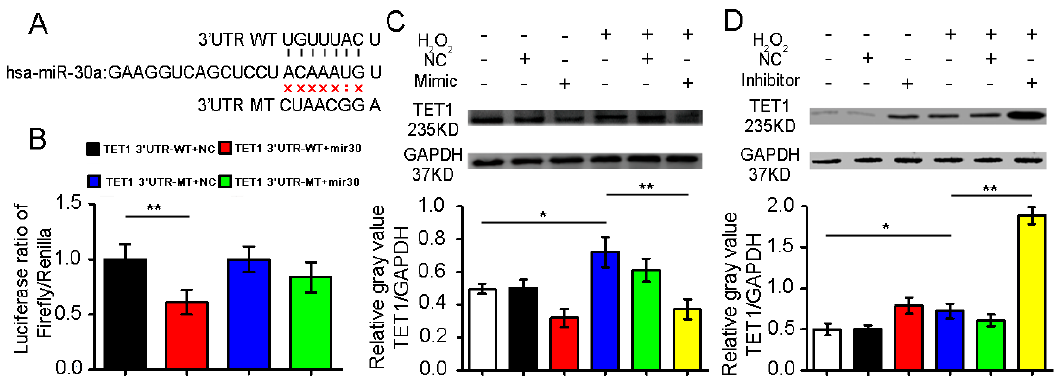
Figure 2. Experimental confirmation of TET1 as a target gene of miR-30a. ( A ) Binding site with miR-30a in 3 (cid:48) UTR of TET1. WT, wild type; MT, mutation type; ( B ) Ratios of firefly/ Renilla in the dual-luciferase reporter system analysis. The luciferase ratio of firefly/ Renilla represents the target gene expression. The luciferase activity of the WT 3 (cid:48) UTR-TET1 significantly decreased in the cells transfected with miR-30a mimic. However, the miR-30a mimic could not inhibit the luciferase activities of the MT 3 (cid:48) UTR-TET1; ( C ) The miR-30a mimic inhibited the expression of TET1 in the A549 cells treated with H 2 O 2 for 24 h. NC is the negative control of the miR-30a mimic; ( D ) The miR-30a inhibitor improved TET1 expression in the A549 cells treated with H 2 O 2 for 24 h. NC is the negative control of the miR-30a inhibitor. +/ − Indicates with or without reagent respectively.The data of each group are presented as mean ± standard deviation (SD), * p < 0.05, ** p < 0.01.